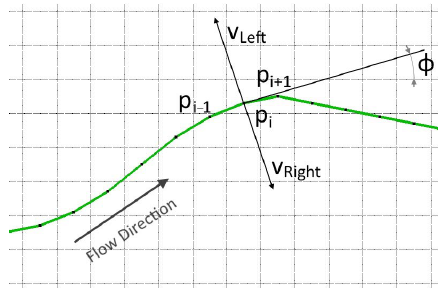
Figure 9. Calculation of the stream angle and the normal vectors.